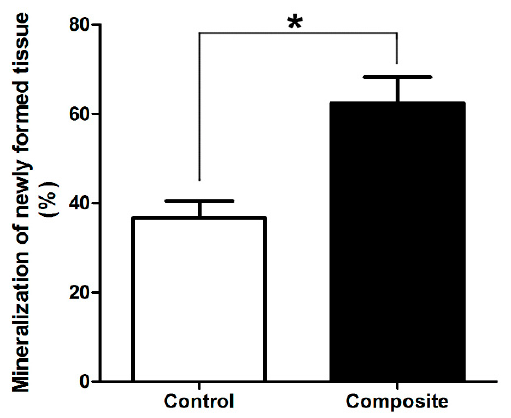
Figure 5. Comparisons of newly formed mineralized tissue. The percent area of new bone and cartilage in the control group was significantly lower than that in the composite group at eight weeks post-implantation (* p < 0.05).